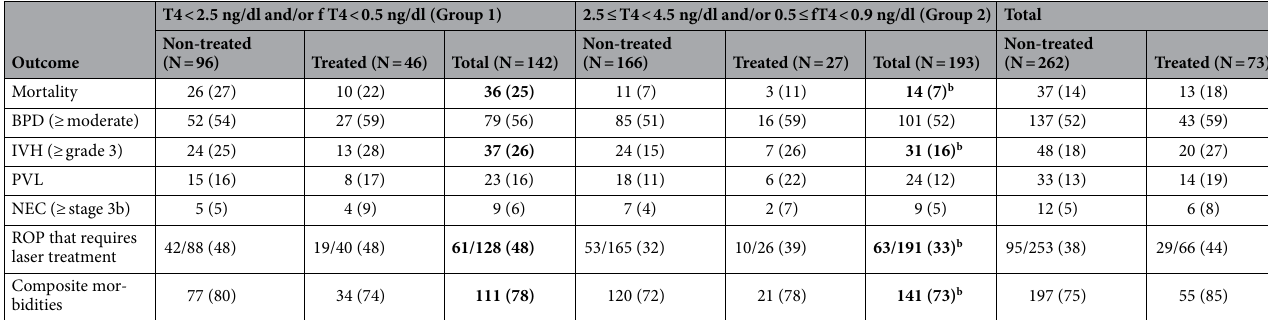
Table 3. Short-term outcomes. Values are presented as n (%). Composite morbidities = BPD (≥ moderate) + IVH (Gr ≥ 3) + NEC (≥ 3b) + ROP that requires laser therapy. Significant values are in [bold]. T4 thyroxine, fT4 free thyroxine, BPD bronchopulmonary dysplasia, IVH intraventricular hemorrhage, PVL periventricular leukomalacia, NEC necrotizing enterocolitis, ROP retinopathy of prematurity. a p < 0.05 compared with non-tereated group. b p < 0.05 compared with group 1.